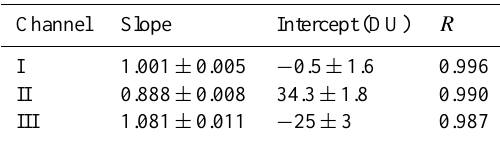
Table 2. Linear fit parameters between Microtops II and Brewer ozone. Only data for airmasses smaller than 3 were